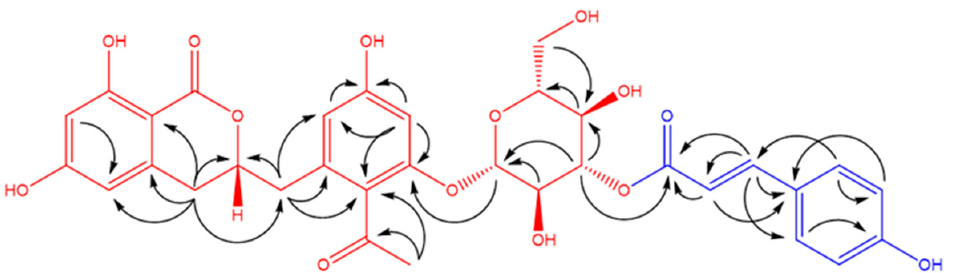
Figure 5. Key HMBC correlations of 2